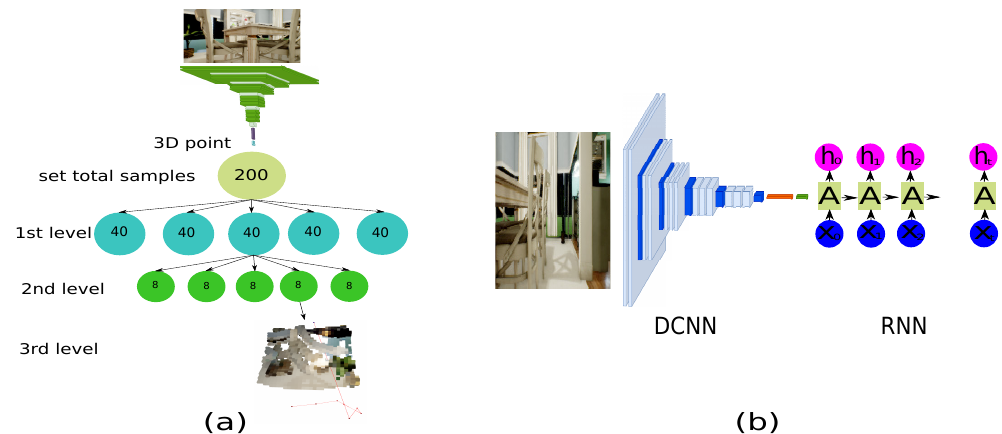
Figure 8. Path generator approaches. ( a ) A hierarchical cluster is composed of the centroid of each set to avoid analyzing whole samples. ( b ) Autoencoder comprises a deep convolutional neuronal network as the encoder and a recurrent neuronal network as the decoder.